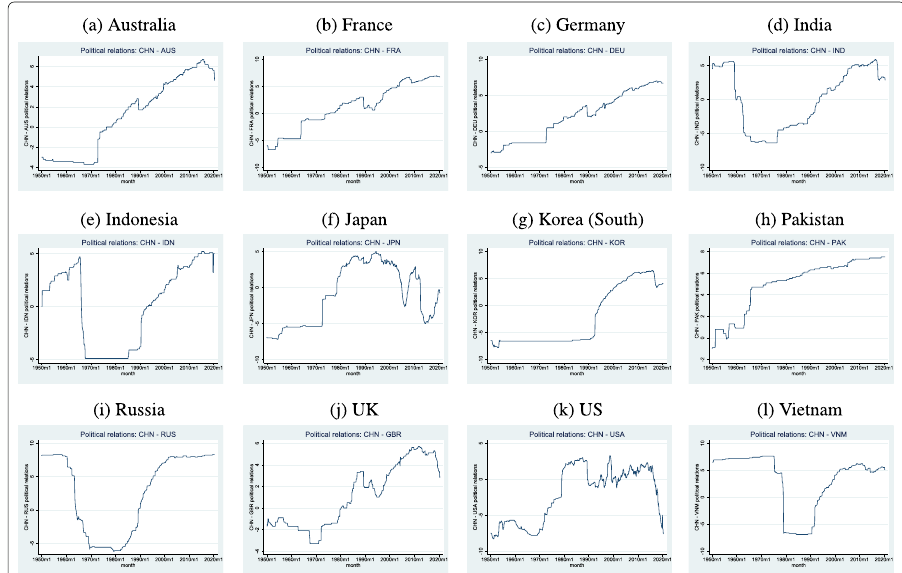
Fig. 1 Trends of the Scores of Political Relationship between China and Its Twelve Trading Partners